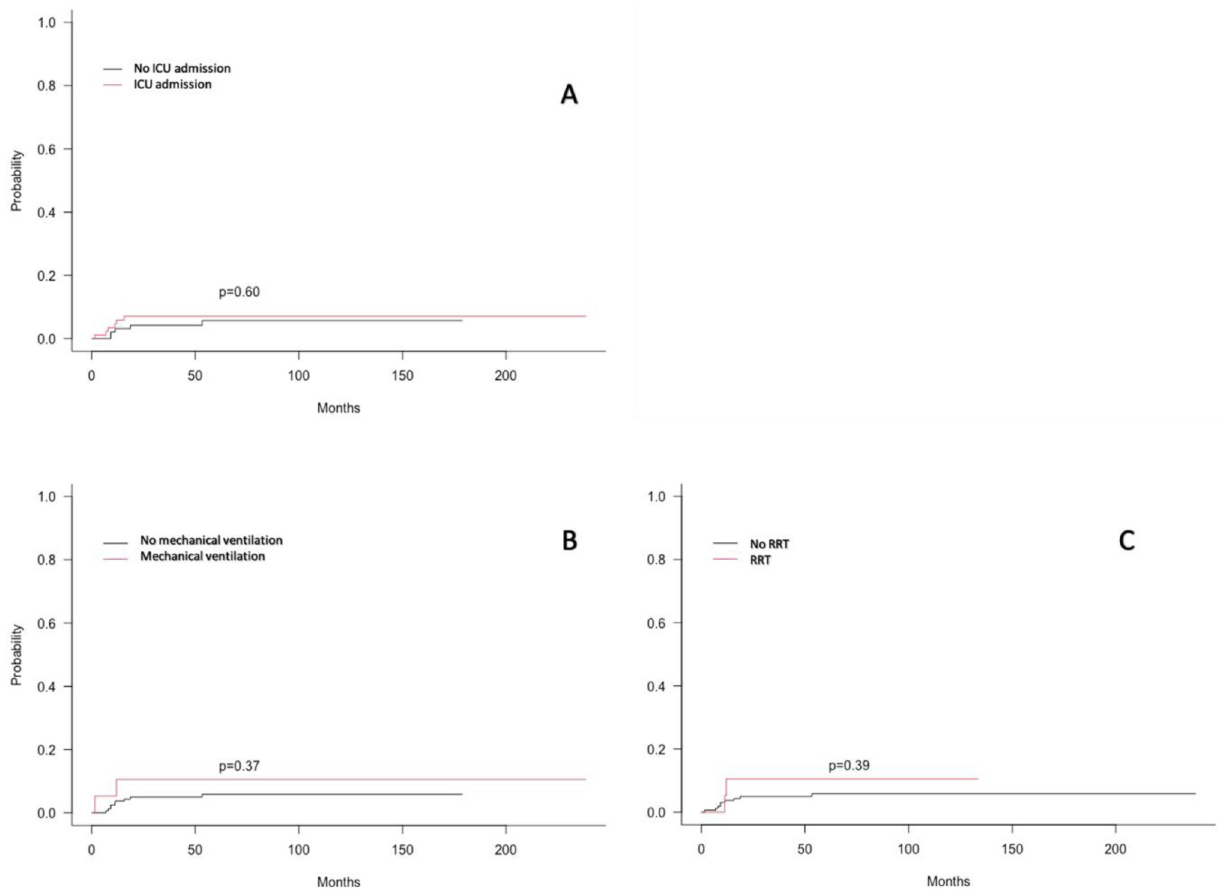
Fig 3. Cumulative incidence of treatment-related mortality. (A): According to ICU admission status; (B): According to mechanical ventilation status; (C): According to renal replacement therapy status.